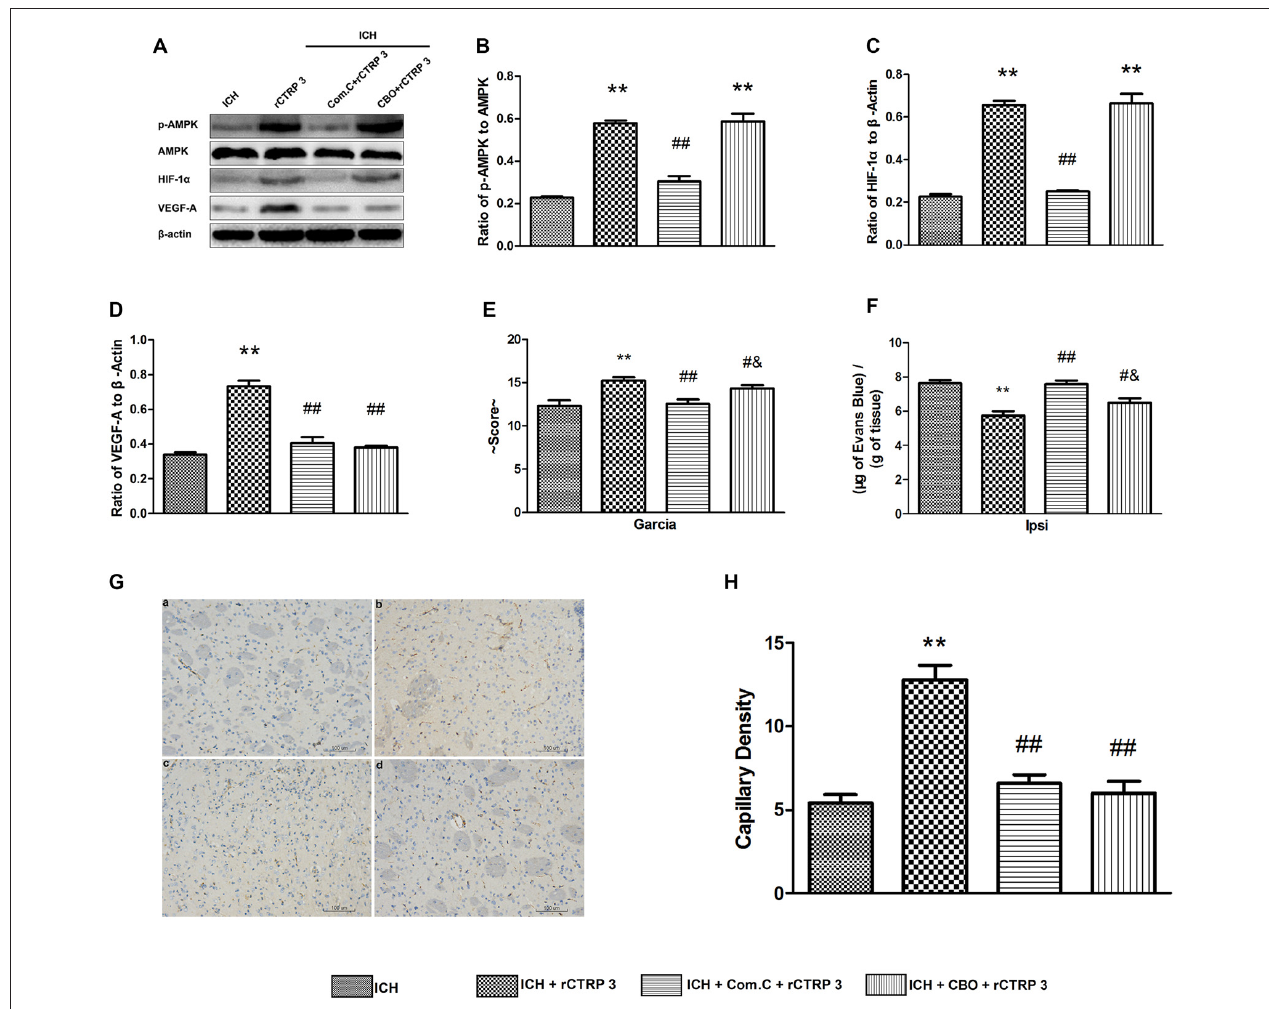
FIGURE 7 | CTRP3 promotes angiogenesis via an AMPK-dependent signaling mechanism. (A) Western blot analysis of the effects of COM.C and CBO on rCTRP3-induced p-AMPK, HIF-1 α and VEGF-A expression. (B–D) Representative ratios of p-AMPK, HIF-1 α and VEGF-A protein expression. (E) Modified Garcia test analysis of the effects of COM.C and CBO on neurological function improvement induced by rCTRP3. (F) Evans blue dye extravasation analysis of the effects of COM.C and CBO on ICH-induced BBB damage reduced by rCTRP3. (G) Immunohistochemical staining analysis of the effects of COM.C and CBO on angiogenesis induced by rCTRP3. Capillary density measured by immunohistochemical staining for CD31 (brown) in the perifocal region in ICH (a) , rCTRP3 (b) , COM.C (c) and CBO (d) 7 days after ICH. (H) Bar graph showing the number of brown stained capillaries. Values are mean ± SEM. n = 4–6 per group. ∗∗ p < 0.01 vs. ICH; # p < 0.05 vs. rCTRP3; ## p < 0.01 vs. rCTRP3; & p < 0.05 vs. COM.C. CTRP3, C1q/tumor necrosis factor-related protein-3; rCTRP3, recombinant CTRP3; Lenti-CTRP3, Lentivirus overexpression of CTRP3; ICH, intracerebral hemorrhage; COM.C, compound C; CBO,